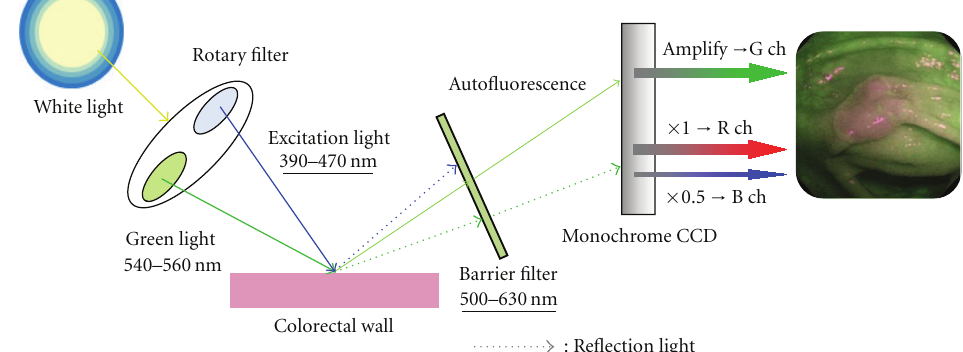
Figure 2: Schematic diagram of the AFI system [19]: white light emitted from a 300-W xenon lamp in the light source is separated with a rotary filter into an excitation light with a wavelength range of 390 to 470 nm and a green light of 540 to 560nm wavelength. These fractionated lights radiate sequentially during the observation period. A barrier filter to remove reflected excitation light is set in front of a monochrome charge-coupled device. Light of 500 to 630nm wavelength is selectively detected from both autofluorescence and reflected green light. A false color image is produced by allocating the detected and amplified autofluorescence signal to the green (G) channel and the reflected signal of green light to the red (R) and blue (B) channels in the ratio of 1 to 0.5.